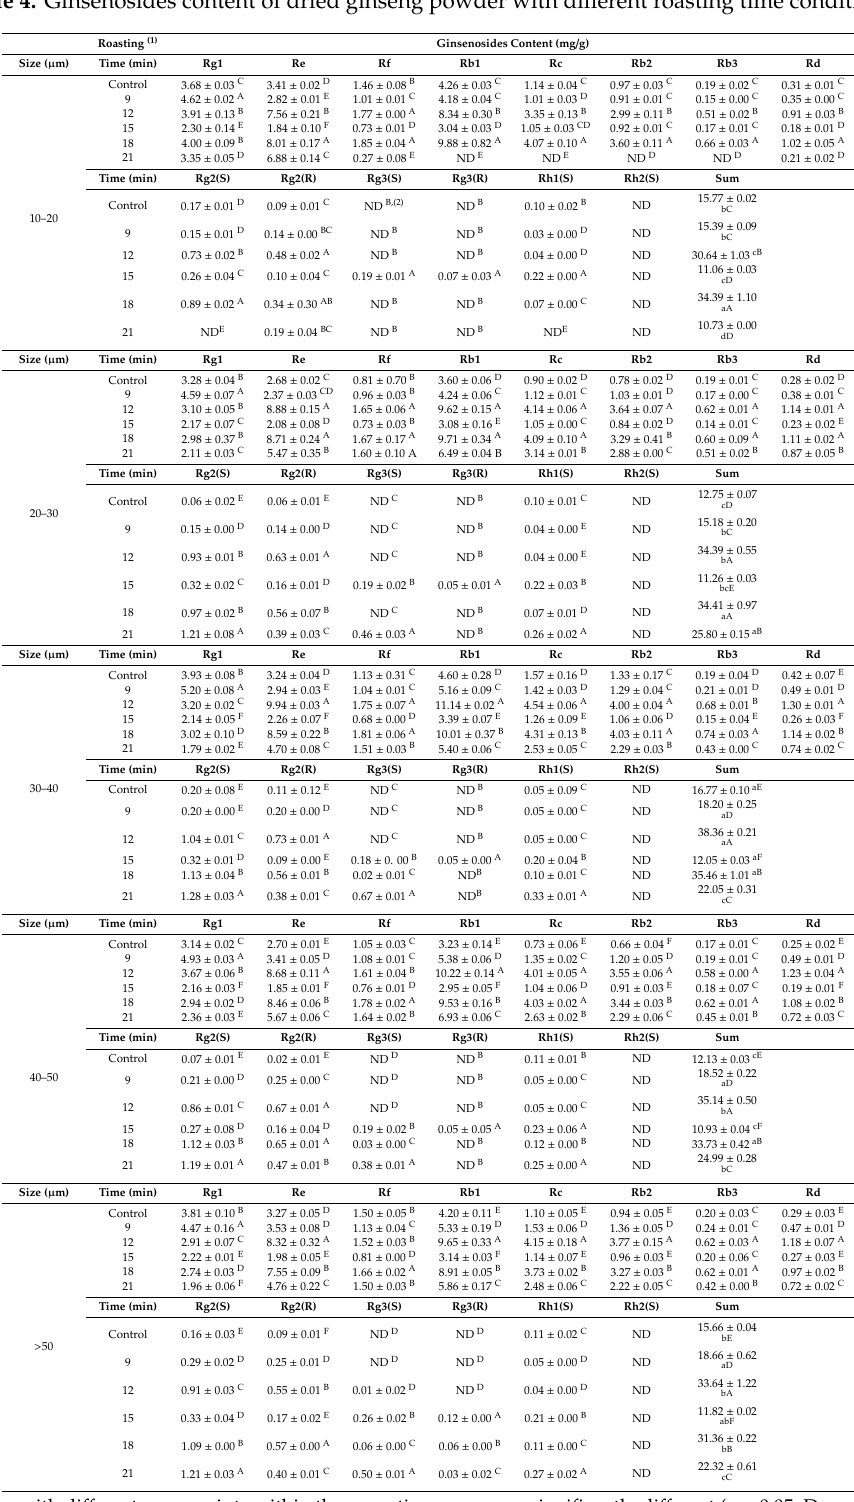
Table 4. Ginsenosides content of dried ginseng powder with di ff erent roasting time